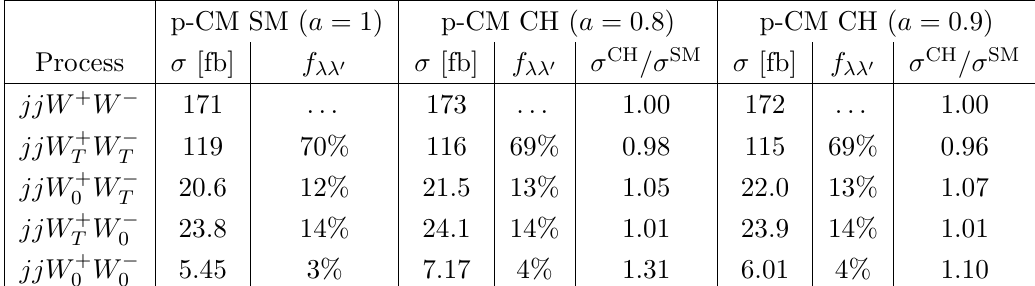
W (cid:0) at (cid:21) (cid:21) 0